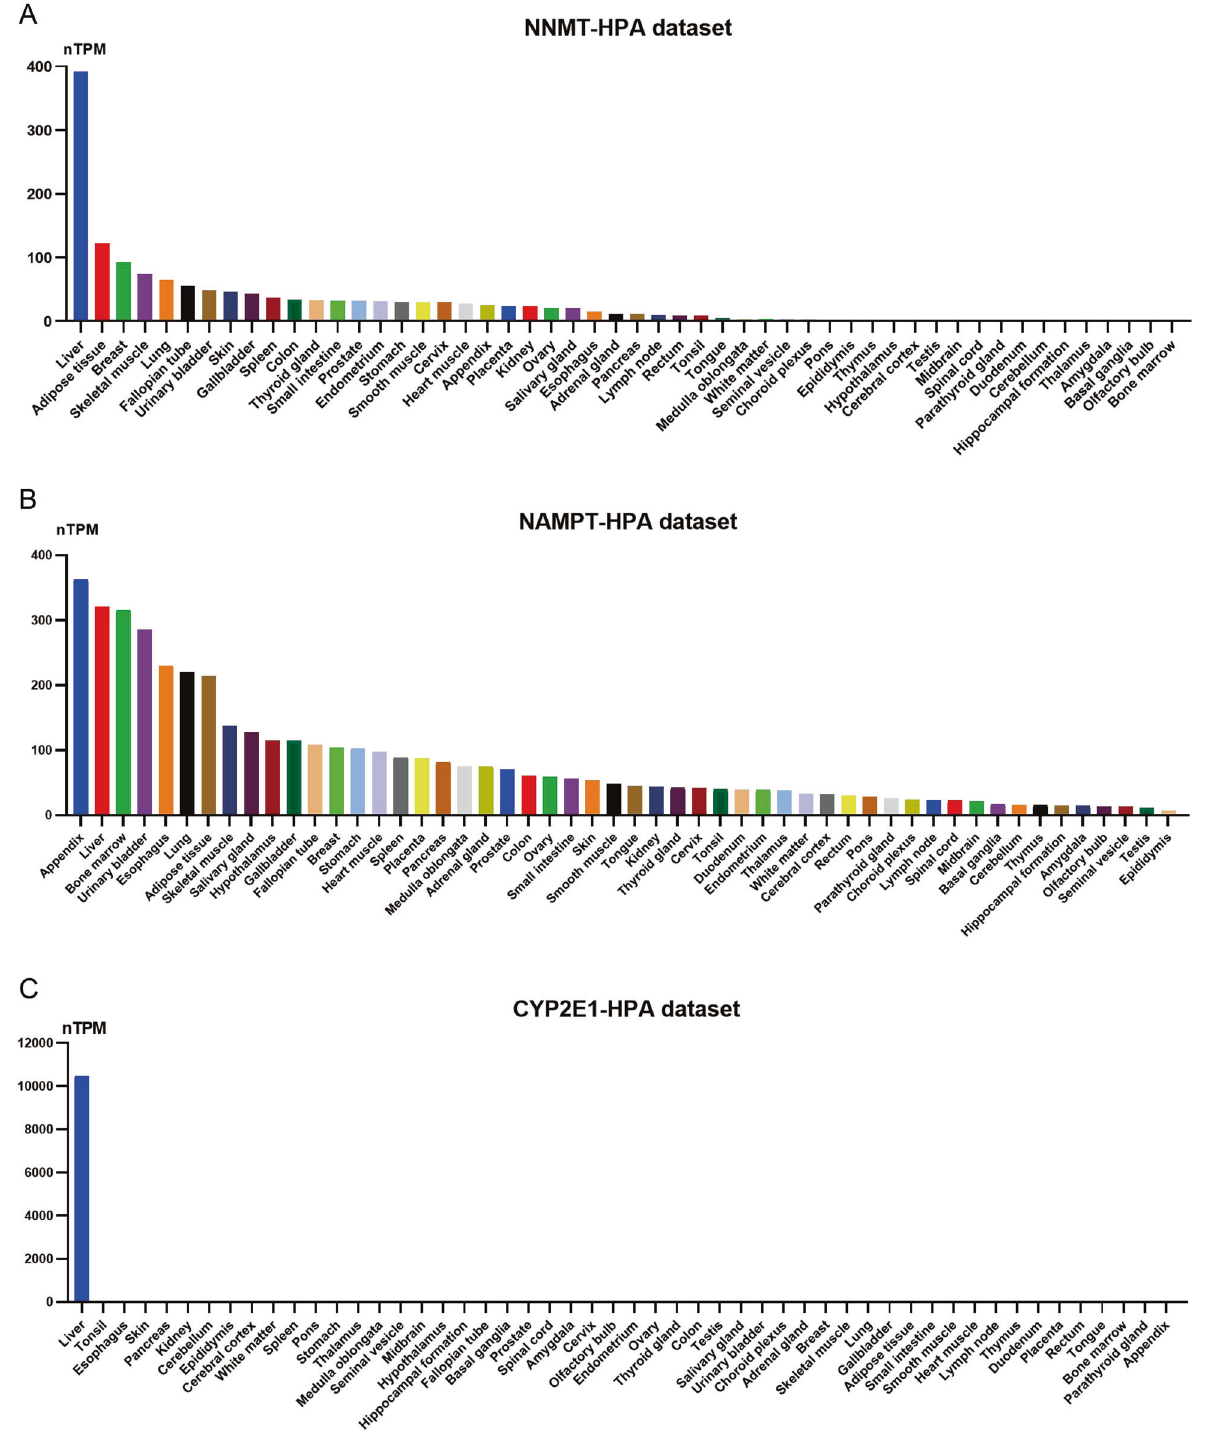
Fig. 2 RNA expression levels of NNMT, NAMPT, and CYP2E1 in different human tissues. Human NNMT and CYP2E1 are preferentially expressed in the liver while NAMPT has low tissue speci fi city. A RNA expression of NNMT in different tissues from the Human Protein Atlas dataset (https://www.proteinatlas.org/). The expression of NNMT is the highest in the liver, and it is also expressed in cardiocytes, smooth muscle cells, adipocytes, cervix, lung, brain, colon, bladder, testis, and placenta to a lesser extent. B RNA expression of NAMPT in different tissues from the Human Protein Atlas dataset. NAMPT is expressed in the appendix, liver, and other tissues, which has low tissue speci fi city. C RNA expression of CYP2E1 in different tissues from the Human Protein Atlas dataset. CYP2E1 is highly expressed in the liver and it is barely expressed in other tissues. nTPM normalized protein-coding transcripts per million.